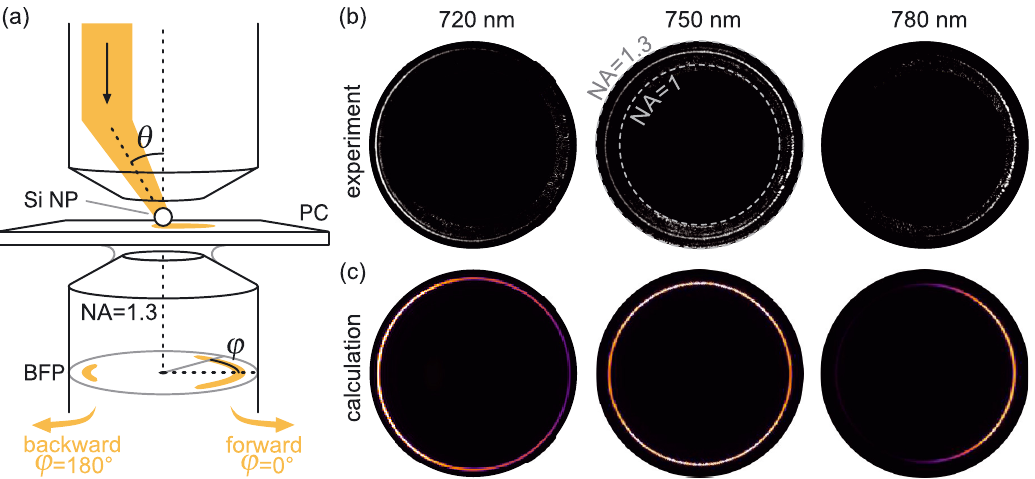
Figure 2: (a) Sketch of the leakage radiation microscopy scheme: Si NP is silicon nanoparticle; PC is photonic crystal; BFP is back focal plane; NA is numerical aperture. (b) Experimental images of the back focal plane for various excitation wavelengths (for NP4). The bright circle between NA = 1 and NA = 1.3 corresponds to the BSW. (c) Numerical simulation of the back focal plane